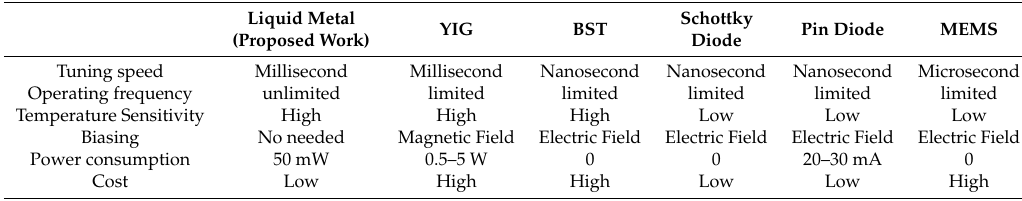
Figure 5. Photograph of ( a ) the fabricated sample of the proposed switchable bandpass-to-bandstop filter, ( b ) the fluidic switch where the liquid metal is in the reservoir, and ( c ) the fluidic switch when the channel is filled by liquid metal. Table 1. Parameters of other tuning techniques